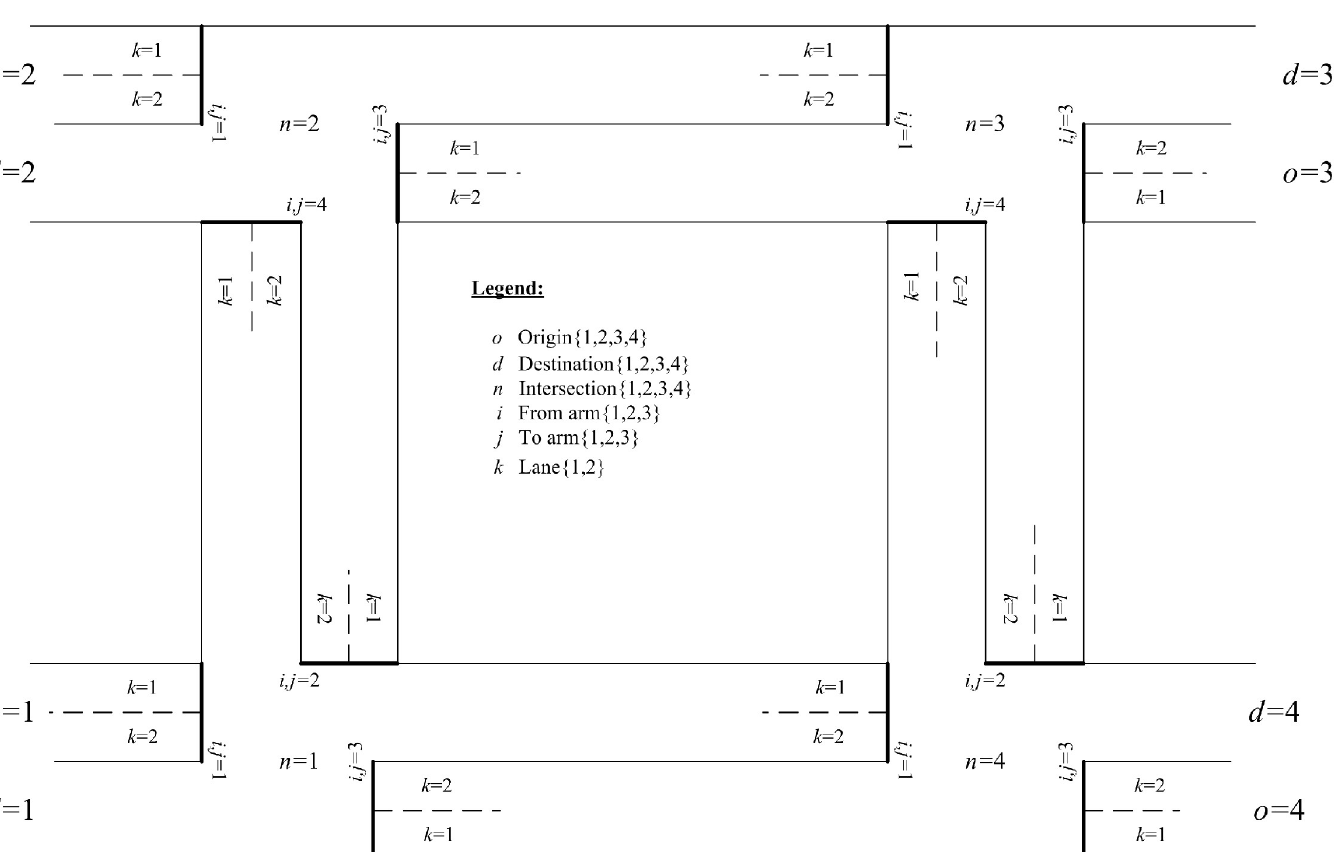
PLOS ONE | https://doi.org/10.1371/journal.pone.0216958 June 10,